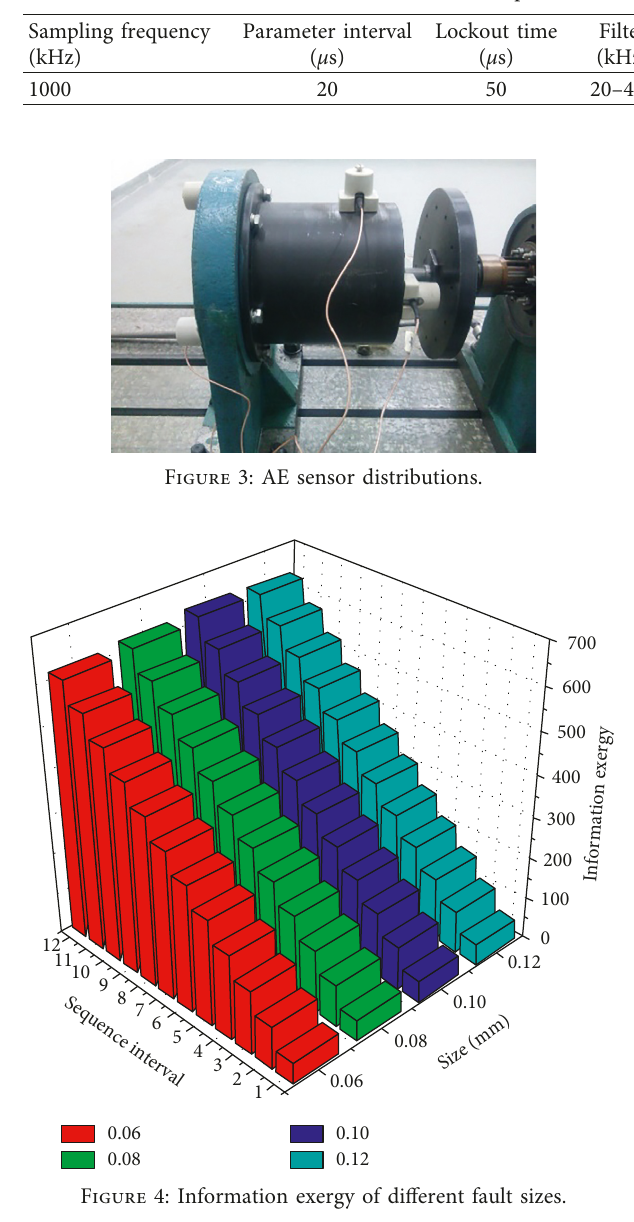
Table 1: Related parameters of the AE data acquisition system.